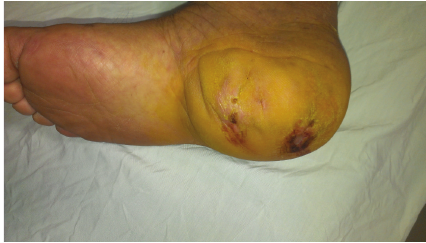
Figure 5: The complete remission of right heel lesion after 4-month treatment with